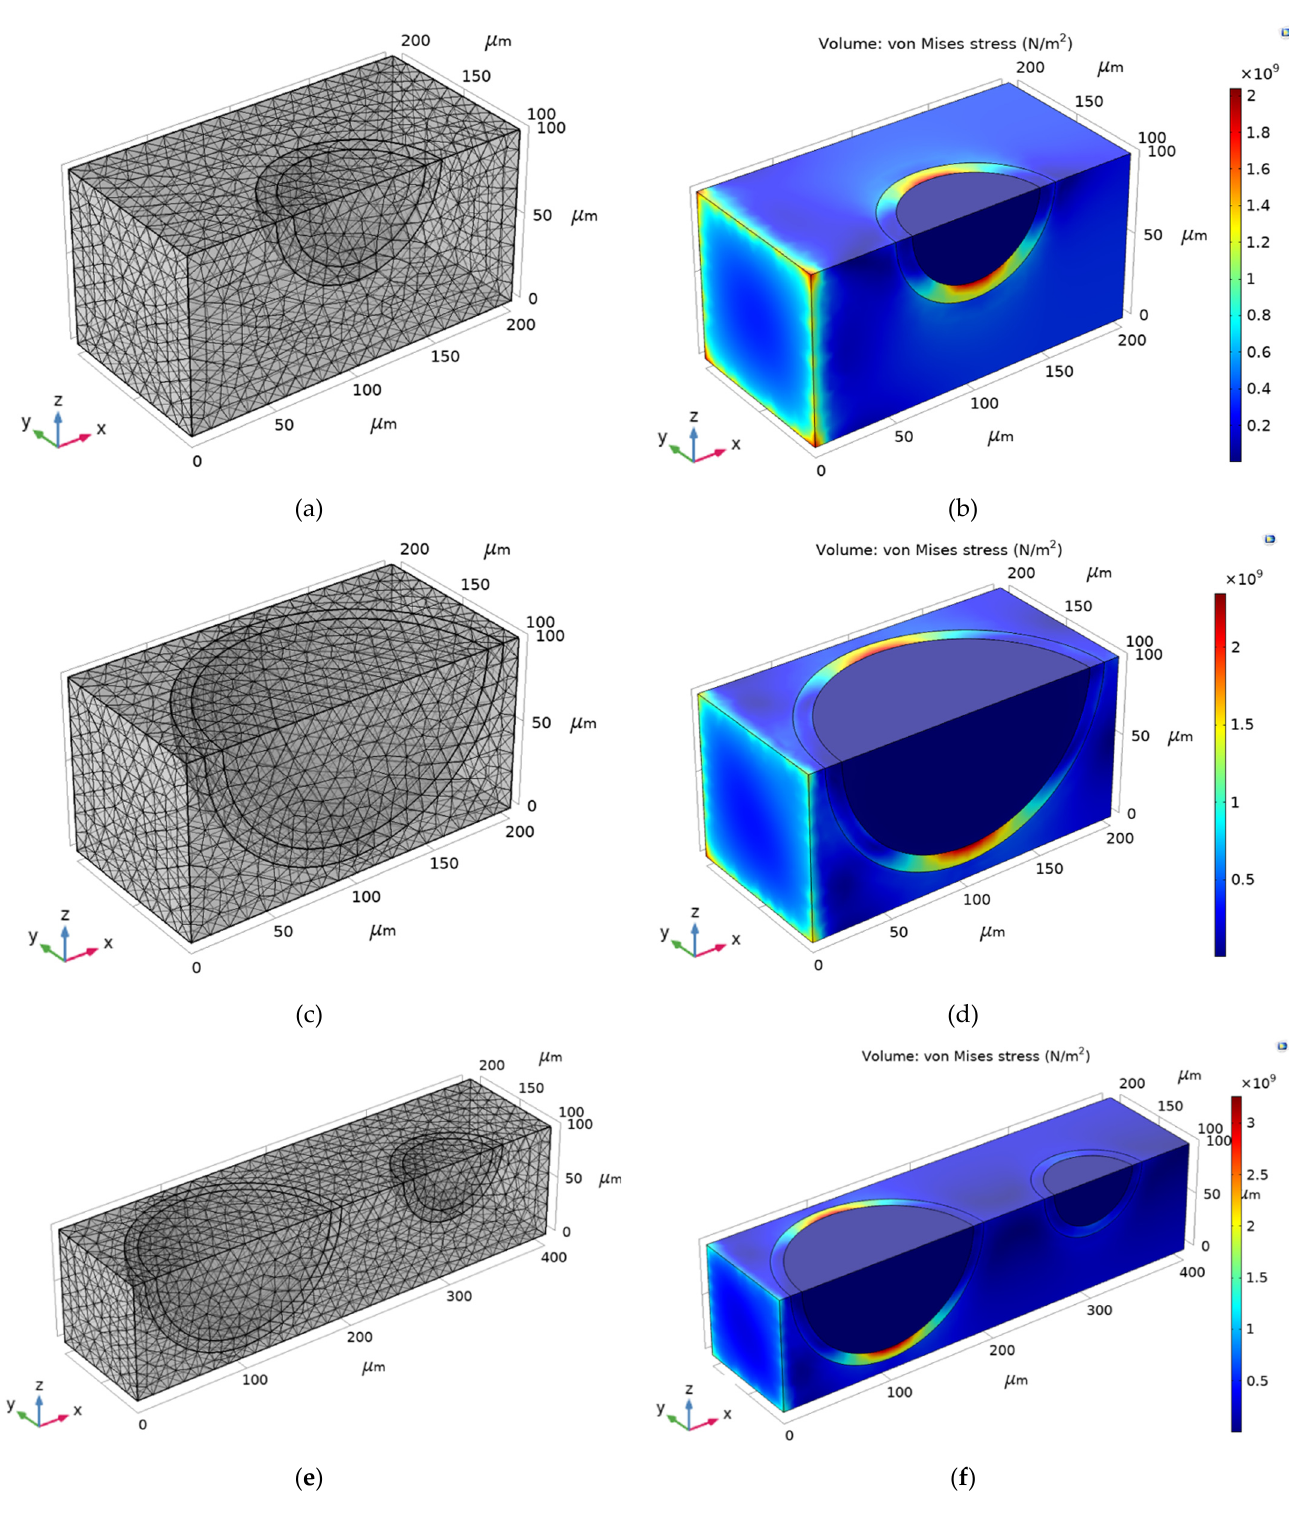
Figure 7. Model of composites: ( a ) Mesh of Composite 1; ( b ) von Mises stress of Composite 1; ( c ) Mesh of Composite 2; ( d ) von Mises stress of Composite 2; ( e ) Mesh of Composite 3; ( f ) von Mises stress of Composite 3.